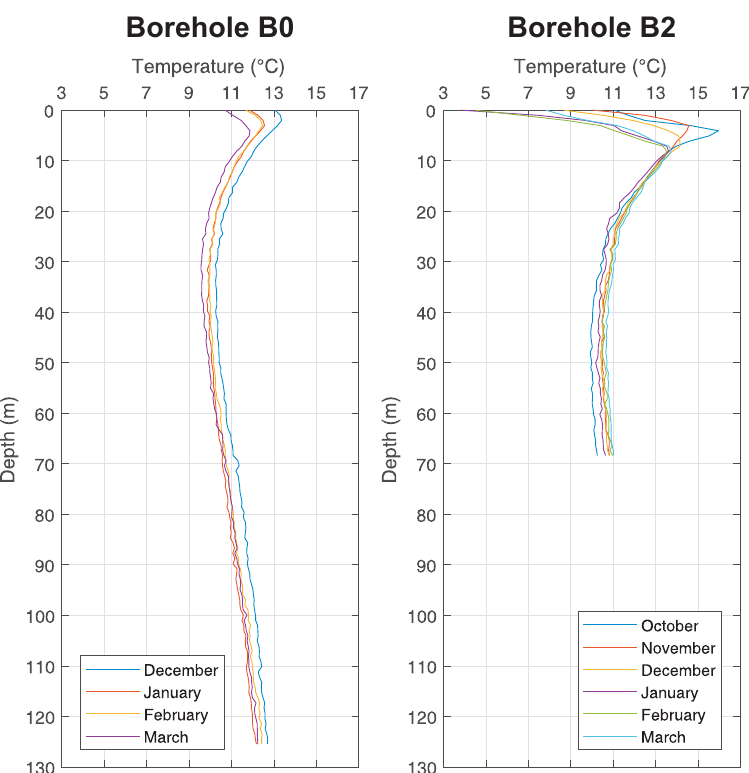
Figure 5. Graph of temperature changes with the depth at chosen monitoring borehole B0 and B2 of the Small Research Polygon .